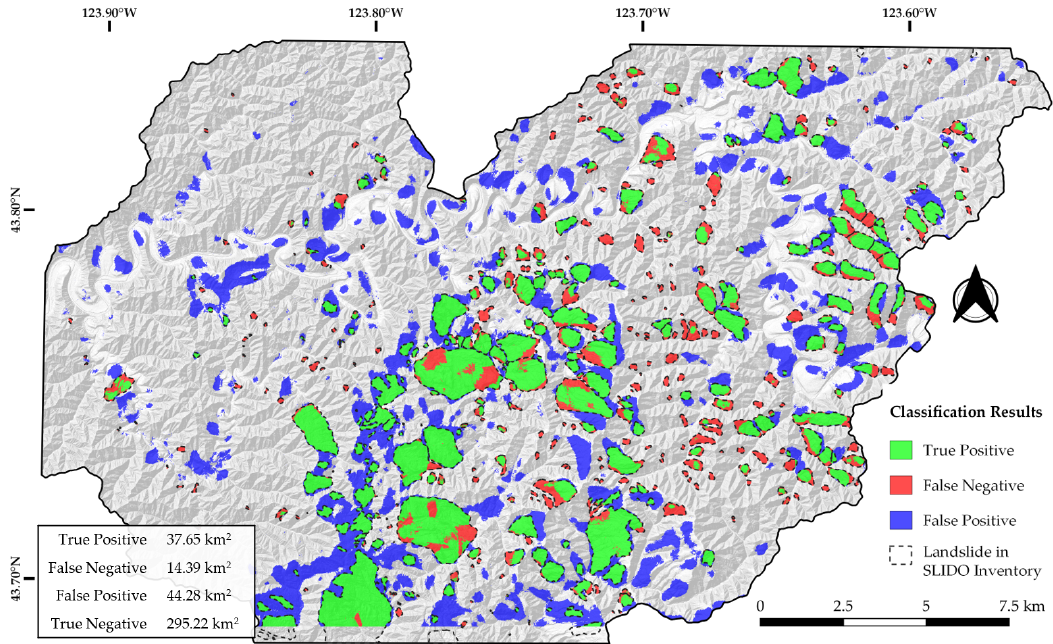
Figure 7. Result of deep-learning method using U-net with ResNet34 backbone (applied to testing area). The map is in UTM Zone 10N with WGS 84 datum